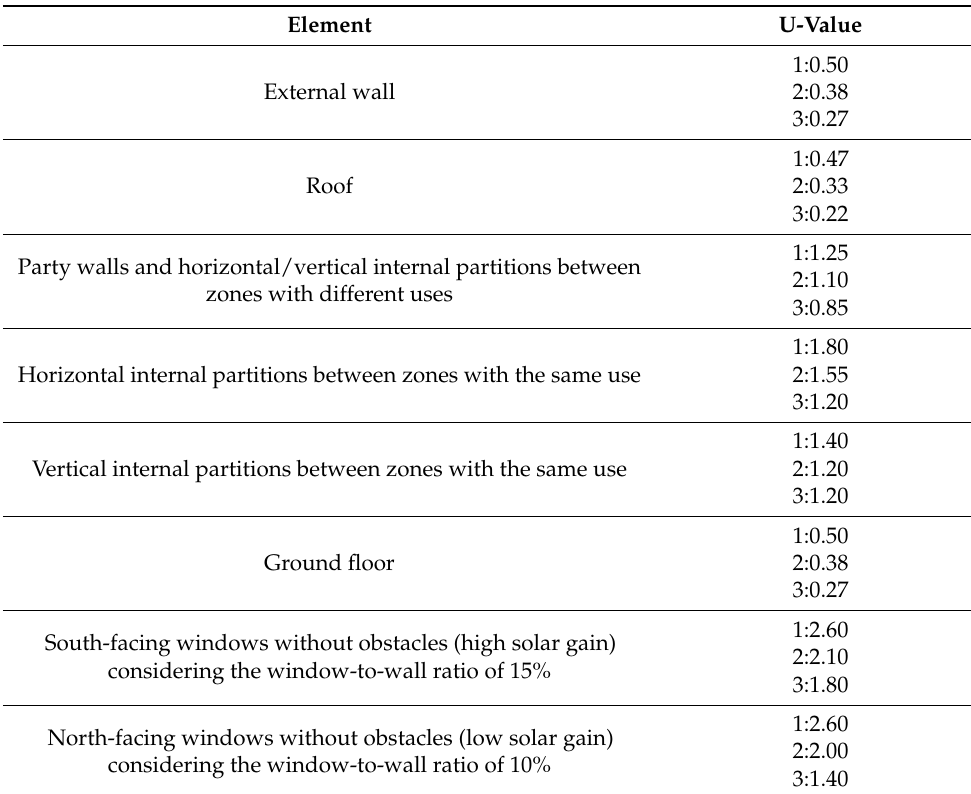
Table A1. Characteristic U-values (W/m 2 K) of the thermal envelope of buildings in each climate zone and the selected building standard. Source: own elaboration based on [27].